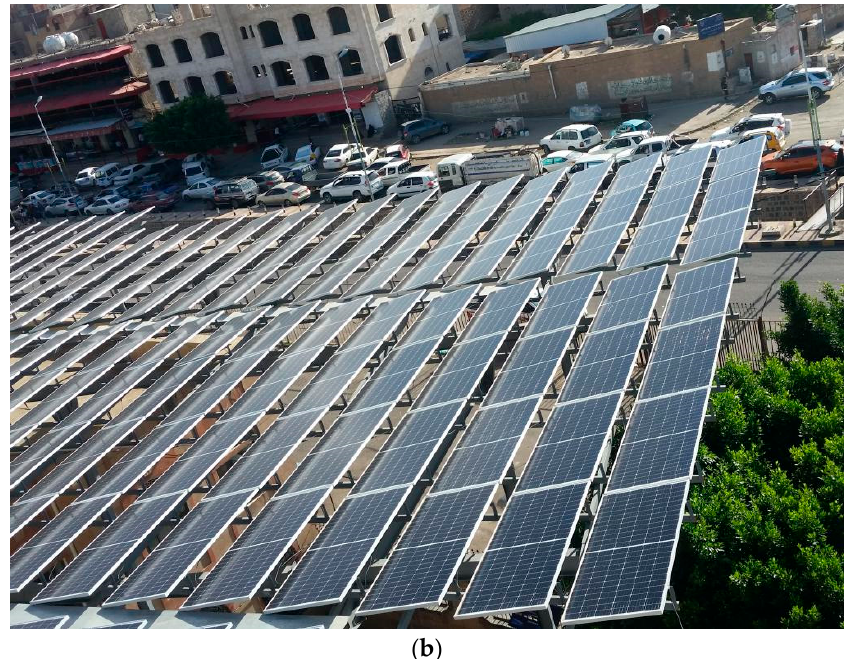
Figure 3. ( a ) Photovoltaic for water pumping and utilities operations: A pumping station of a private water well run on solar energy in the capital city of Sana’a. ( b ) Solar panels on the roof of a building of the Sana’a Water and Sanitation Corporation for operating a public water well nearby (pictures by the authors).